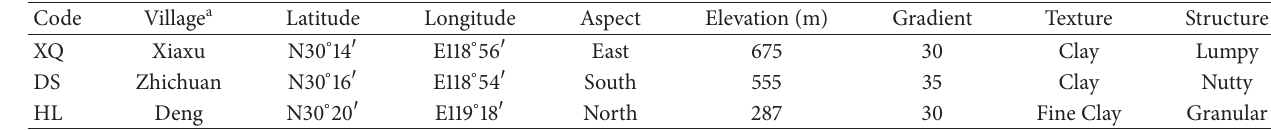
Table 1: Basic information of three fixed sample